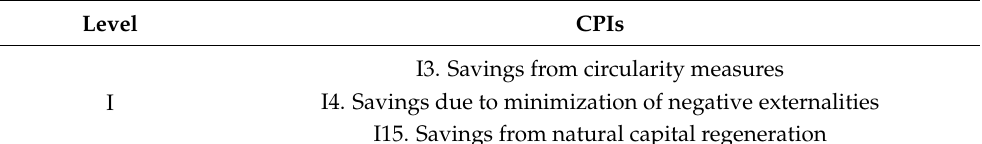
Table 4. Importance levels of the